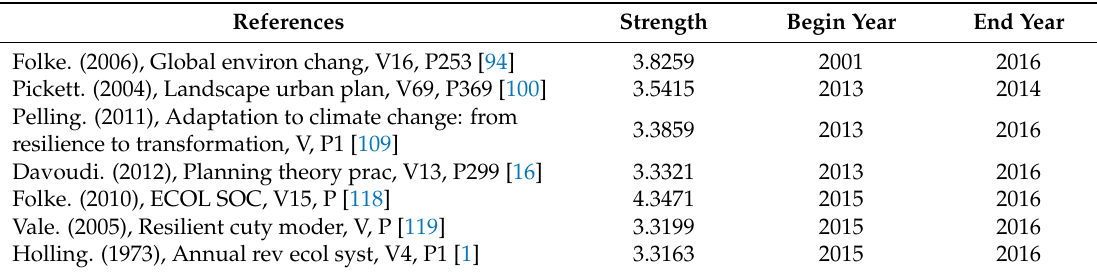
Table 8. The top 7 references with strongest citation